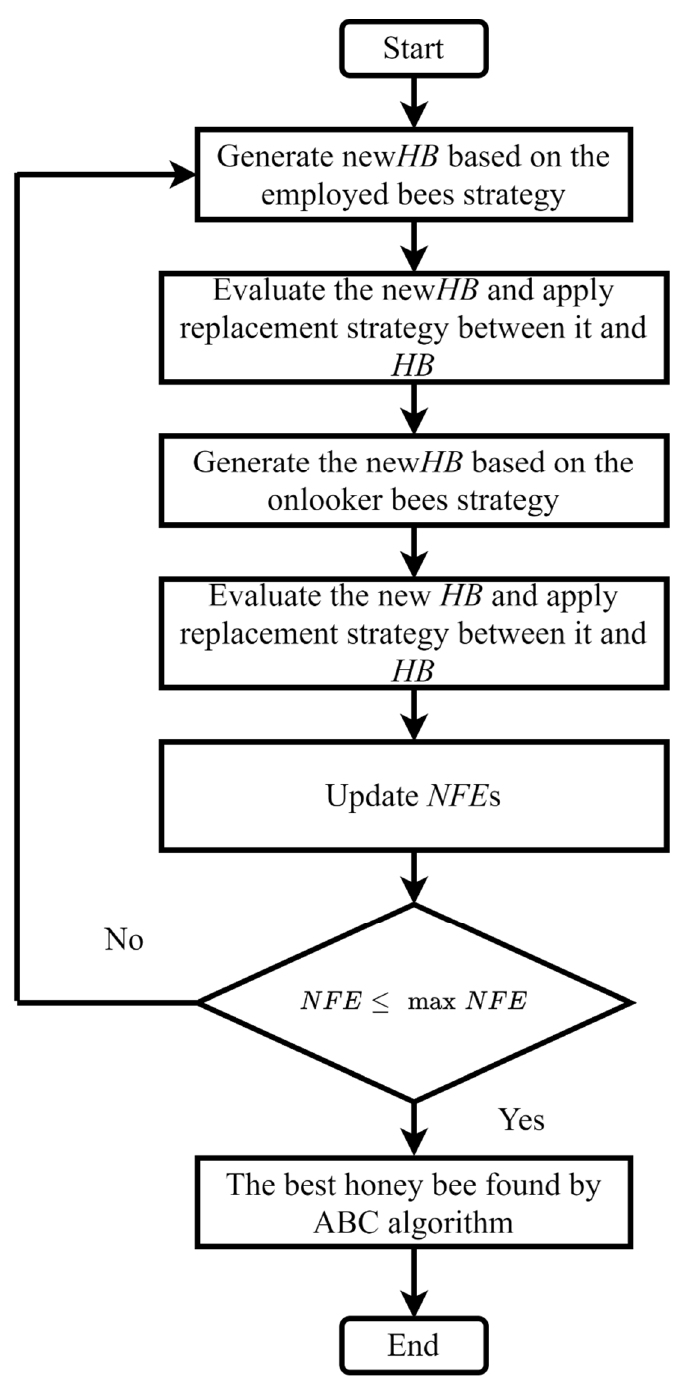
Figure 11. Framework of Artificial Bee Colony Algorithm [76].